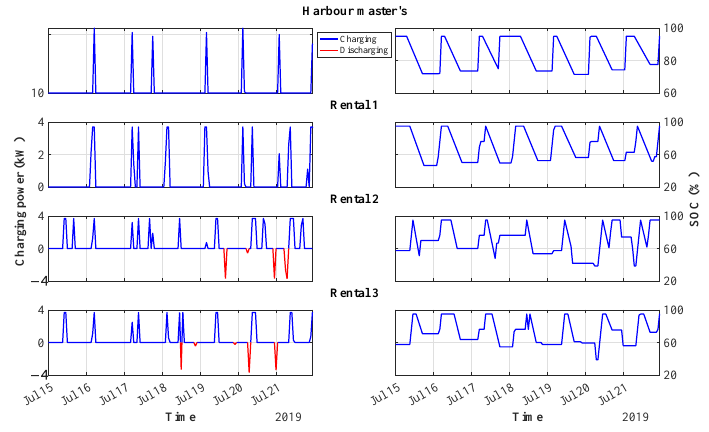
Figure 10. Optimal bidirectional power flow